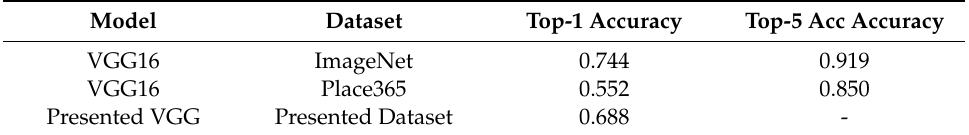
Table 5. Performance comparison between the trained model and models trained on other domains.